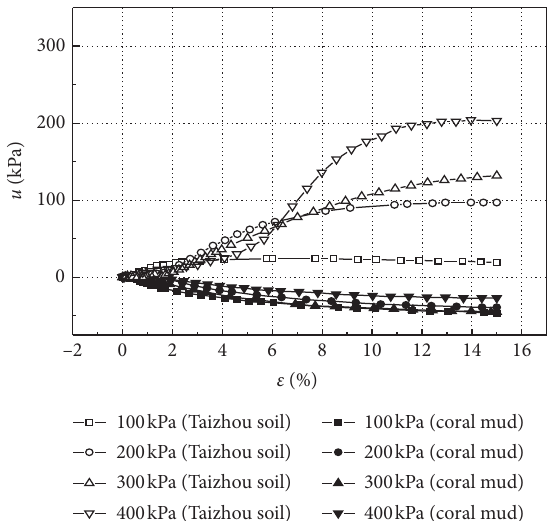
Figure 8: Pore pressures under different confining